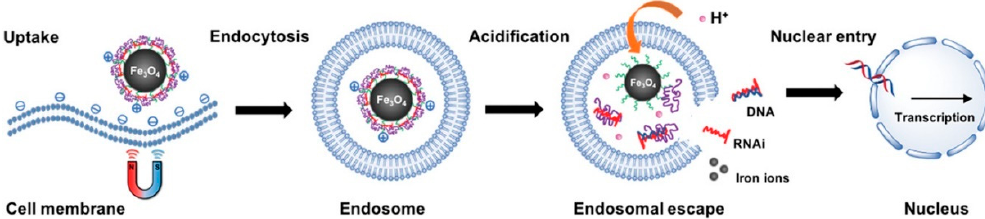
Figure 1. Magnetofection using magnetic nanoparticles. The plasmid DNA is associated with magnetic nanoparticles, which are directed, attracted, and concentrated on the surface of cell membranes, where the endocytosis process brings the nanoparticles into the cell. Adapted with permission from [43].